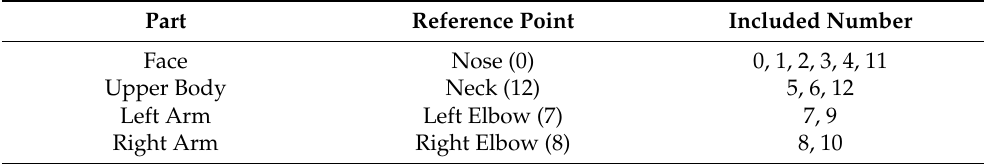
Table 1. List of keypoints. We divided them into four parts except for the hands. The number is the index number of the corresponding part, and the reference point is the body part that provides the reference for each part. Part Reference Point Included